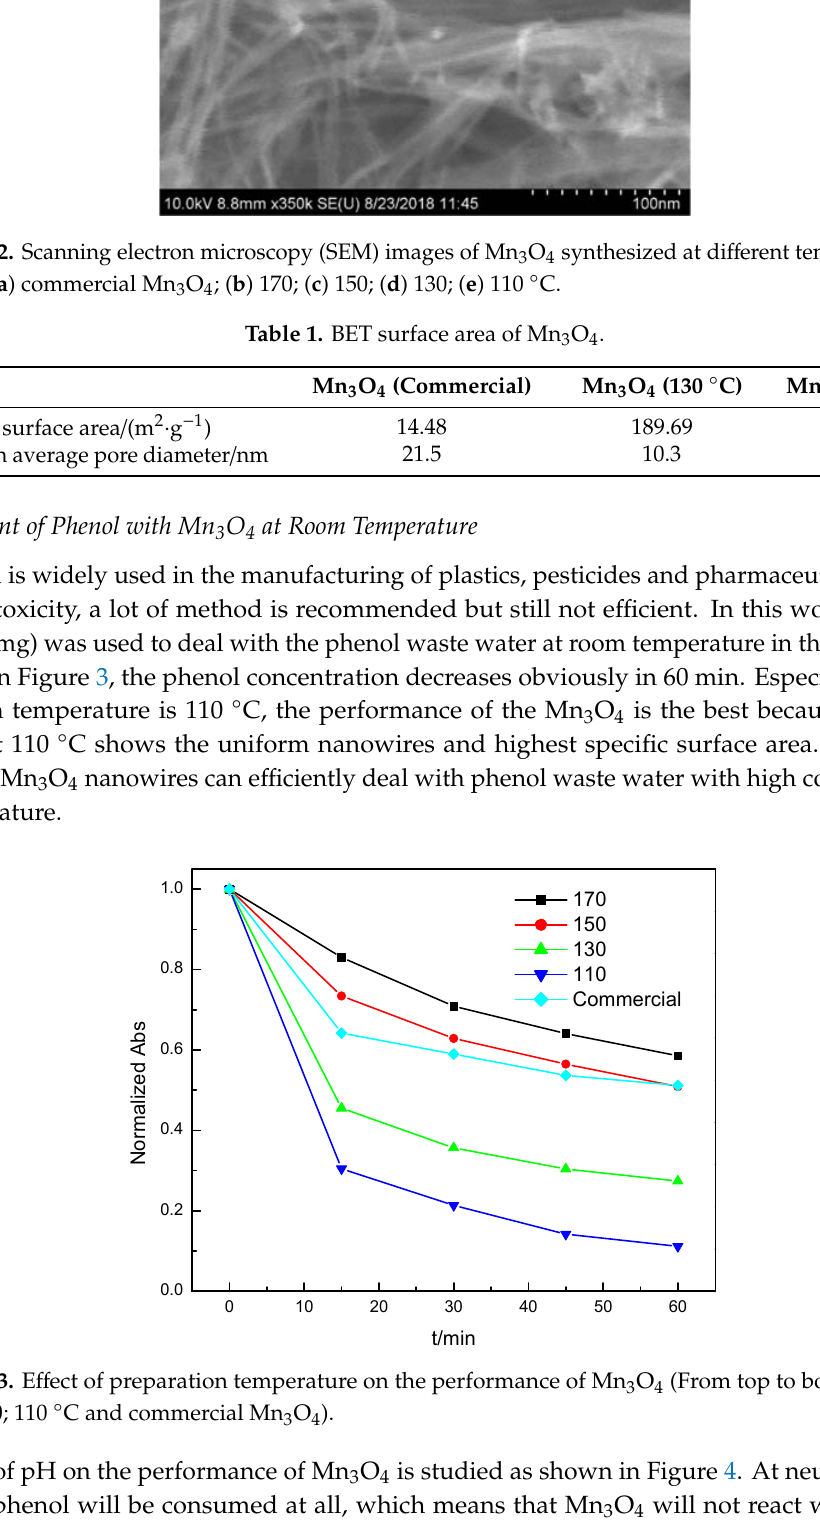
Figure 4. Effect of pH on the performance of Mn 3 O 4 . 3.3. Analyse of the Function of Mn 3 O 4 in the Treatment of Phenol Different reaction atmosphere is utilized to investigate the mechanism of phenol treatment. As shown in Figure 5, in all the reaction condition, the Mn 3 O 4 has the similar performance which means oxygen is not necessary for the treatment of phenol waste water. In the product of the reaction, benzoquinone was detected which means Mn 3 O 4 nanowires can oxidize phenol at room temperature. H 2 O 2 is an effective oxygen content with low cost and environmentally friendly nature. The excess H 2 O 2 can decompose into safe H 2 O and O 2 [20]. However, H 2 O 2 (0.1 mol ∙ L − 1 ) cannot oxidize phenol at the same pH in air condition. In contrast, Mn 3 O 4 nanowires prepared in this work with